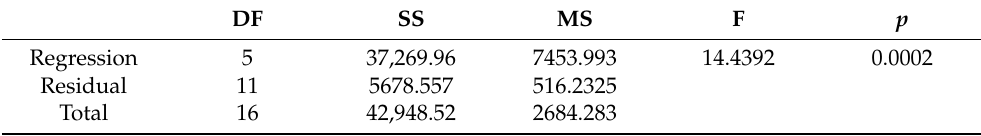
Figure 5. Contour lines of hydrogen production potential ( P s , mL H 2 /g VS) against food waste composition and volatile solid (VS) concentration. Table 4. Analysis of variance for hydrogen production